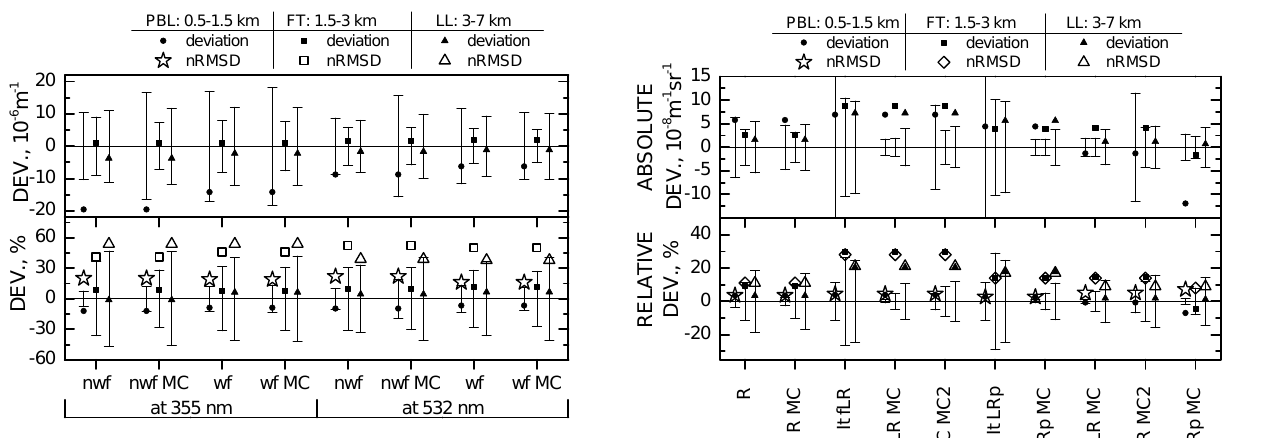
Figure 11. Layer mean absolute (top) and relative (bottom) devi- ations between particle extinction coefficient profiles at 355 and 532nm calculated by ELDA and the simulation input profile for three different altitude regions PBL, FT, and LL (filled symbols). Open symbols show the root-mean-square deviation which was nor- malized with the mean value of the input profile (nRMSD) of the corresponding layer. The error bars indicate the uncertainties esti- mated by ELDA. They are layer mean values of the profiles of ab- solute (top) and relative (bottom) uncertainties. The error bars are centered around the zero line and allow for a direct comparison be- tween estimated uncertainties and deviations. The tested methods are identified by short IDs corresponding to Table 2.